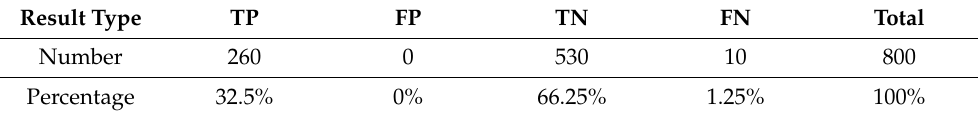
Table 3. Testing results.